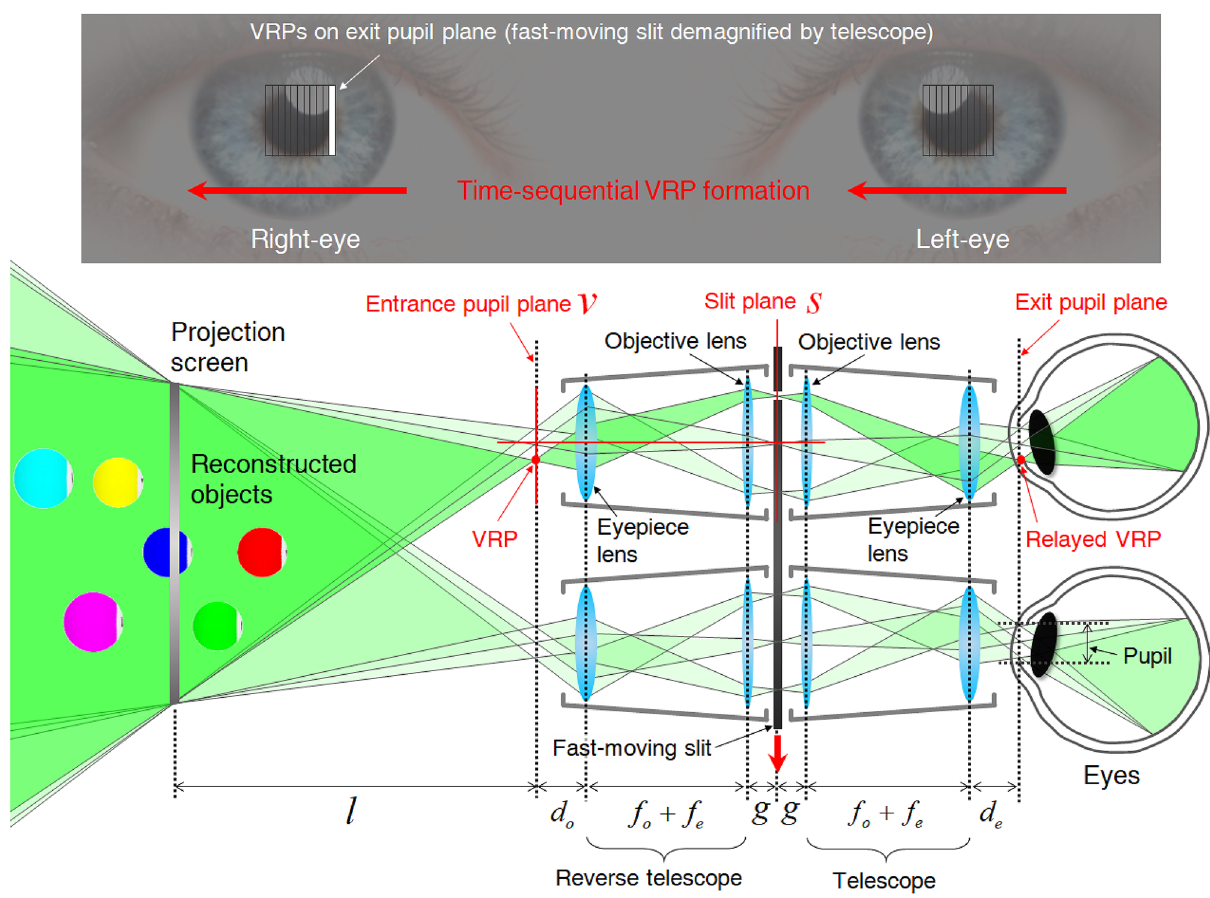
Figure 2. Optical scheme for the proposed BTS HDSMV system. Based on the position of the open slit, VRPs shift and appear at different positions on the exit pupil